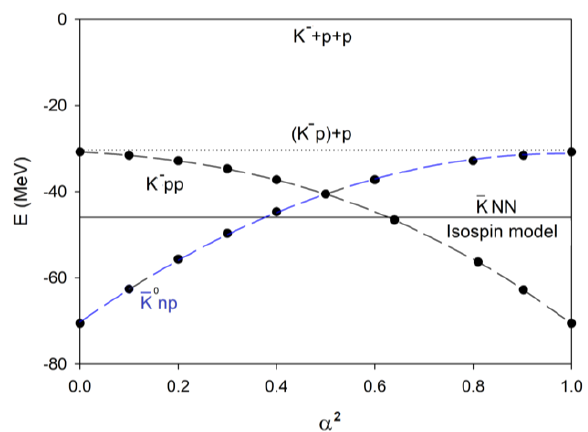
Figure 2: The binding energies of the ppK − and np ¯ K 0 states as solutions of Eq. (6) = 0 and V = 0 for different values of the coupling parameter α . The when V 12 21 difference of the masses of kaons does not taken into account. The energies are measured from three-body threshold. The energy of two-body threshold is shown by the dotted line, while the solid line presents the energy of quasi-bound state obtained within the isospin